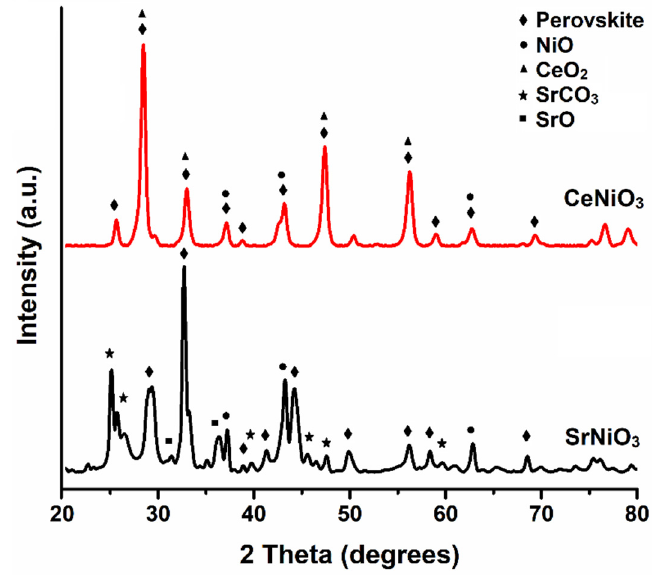
Figure 2. XRD patterns of SrNiO 3 and CeNiO 3 perovskites. Table 1. DTG decomposition temperatures of SrNiO 3 and CeNiO 3